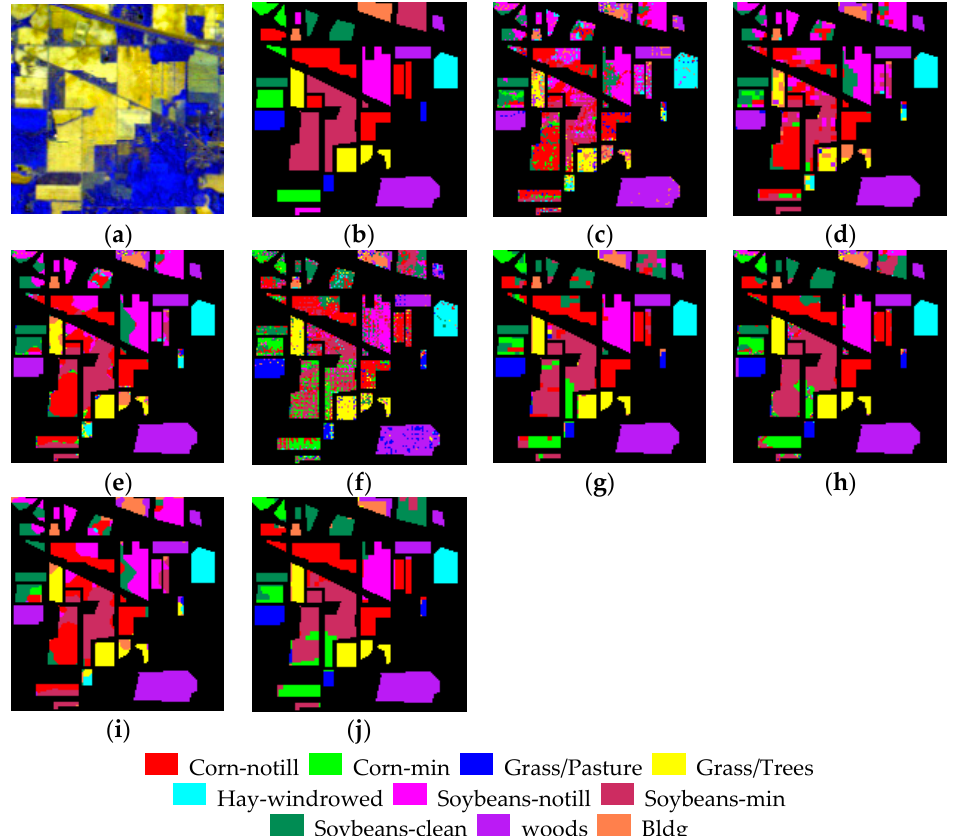
Figure 5. Sub-pixel mapping results for the synthetic dataset (AVIRIS): ( a ) original high-resolution hyperspectral imagery; ( b ) the ground truth data as the reference classification map; ( c ) sub-pixel mapping result obtained using FCLS+AM, ( d ) FCLS+HC, ( e ) FCLS+HNN, ( f ) SUnSAL-TV+AM, ( g ) SUnSAL-TV+HC, ( h ) SUnSAL-TV+HNN, ( i ) MRF, ( j ) JSSM.